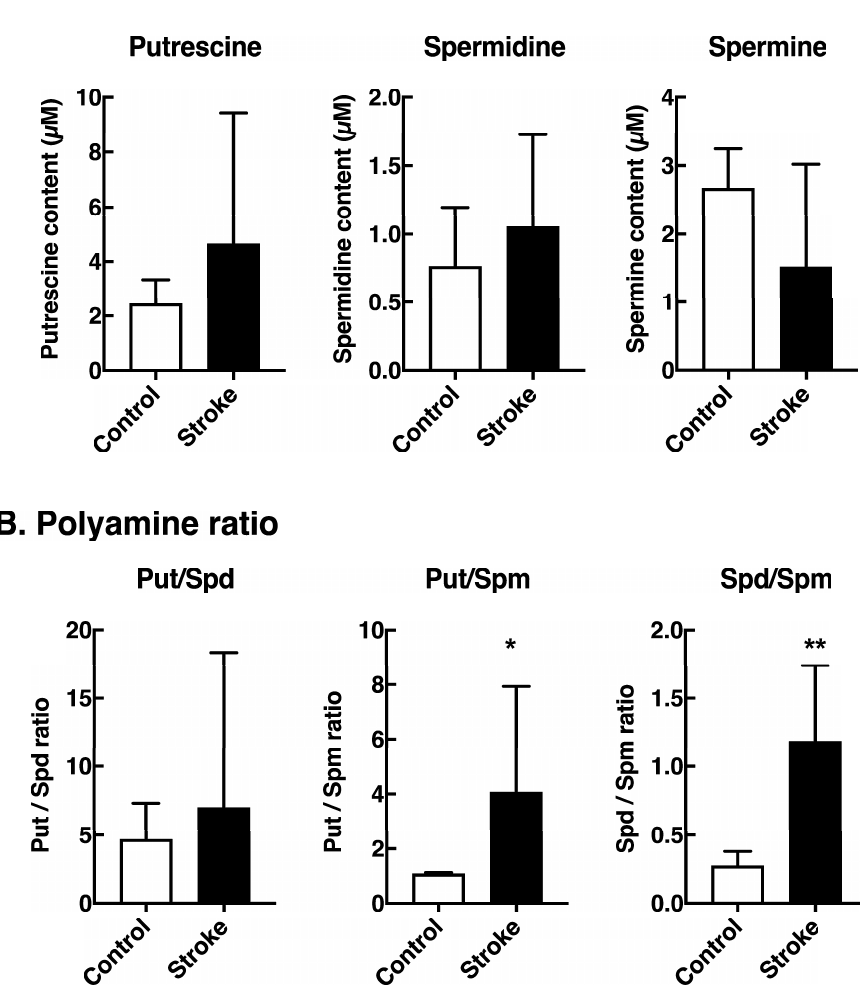
Figure 3. Polyamine content in urine from stroke patients and control subjects. ( A ). Polyamine contents in urine were measured by HPLC [16] and shown as mean + SD. ( B ). The ratio of putrescine / spermidine, putrescine / spermine and spermidine / spermine were calculated and plotted as mean + SD. The significance of di ff erence was calculated using unpaired t test with Welch’s correction. Put, putrescine; Spd, spermidine; Spm, spermine. * p < 0.05, ** p <